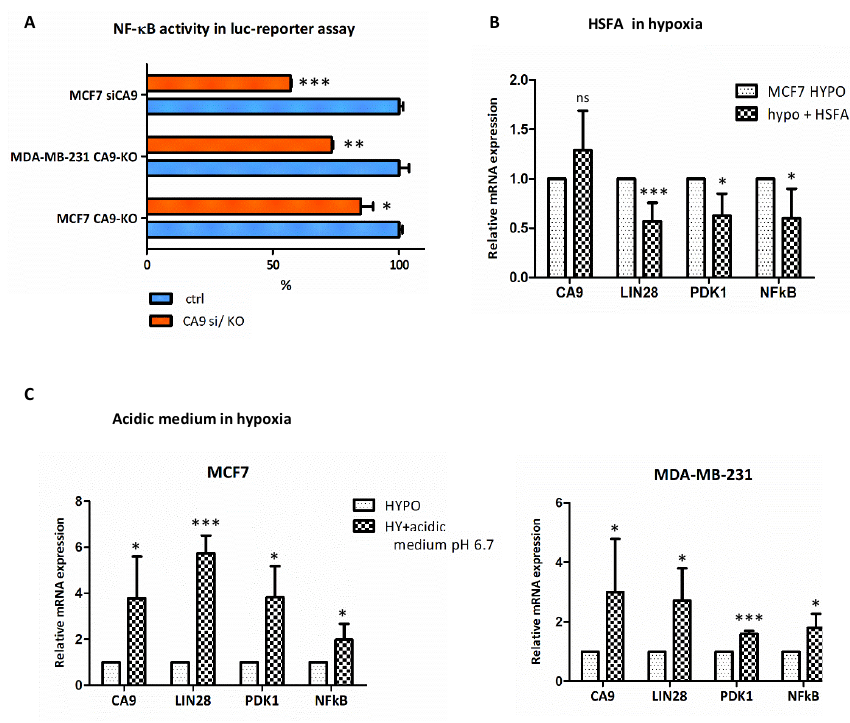
Figure 3. Relationship of CAIX to NF-κB. ( A ) CAIX depletion reduces NF-κB activity. Luciferase assay monitoring the activity of the NF- κ B reporter vector in hypoxic cells with induced CAIX expression (100%) in comparison to CAIX-knockout MCF7-CA9-KO, MDA-MB-321-CA9-KO, and transiently silenced MCF7-siCA9 cells. ( B ) Impact of CAIX enzymatic inhibition by HSFA (100 µ M) on CA9, LIN28B, PDK1, and NF- κ B mRNA expression in hypoxic MCF7 cells. ( C ) E ff ect of modified acidic medium pH 6.7 on the set of the same genes mRNA expression in hypoxic MDA-MB-231 and